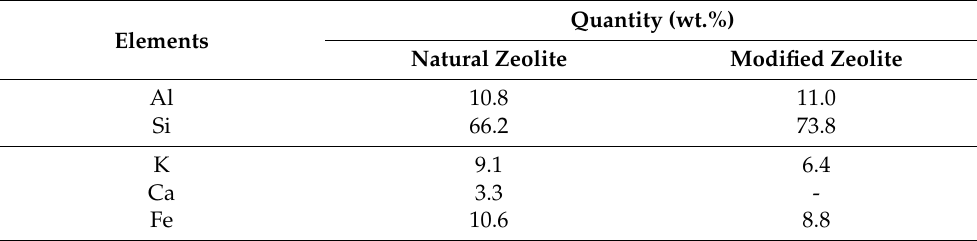
Table 2. Elemental analysis